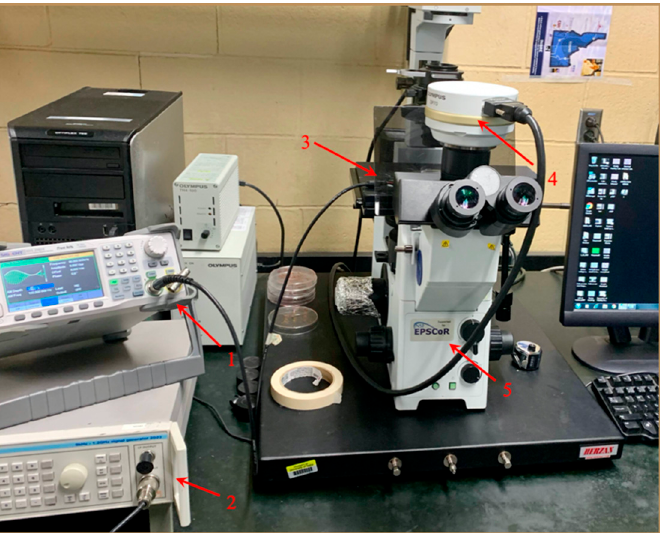
Figure 2. Image showing the experimental setup where the labeled parts refer to ( 1 ) function generator (up to 80 MHz) for f x 1 experiments, ( 2 ) function generator (up to 1200 MHz) for f x 2 experiments, ( 3 ) stage on which the dielectrophoretic (DEP) microwell is placed, ( 4 ) camera to record/visualize the experiments, and ( 5 ) Olympus IX-71 Inverted